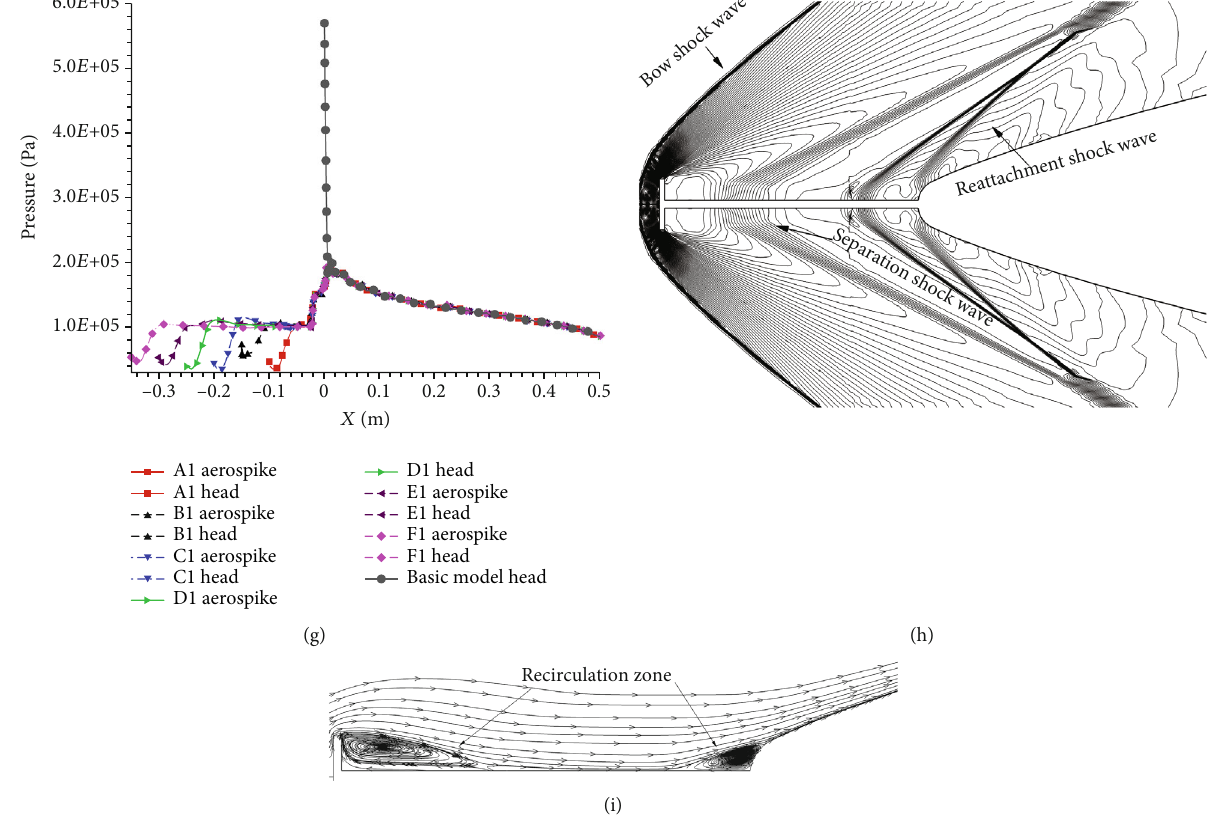
Figure 11: Flow fi eld features in Mach number 2. (a) L = 100 mm and r = 10 mm , pressure contour. (b) L = 200mm and r = 10 mm , pressure contour. (c) L = 350mm and r = 10 mm , pressure contour. (d) L = 100 mm and r = 10mm , velocity contour. (e) L = 200mm and r = 10mm , velocity contour. (f) L = 350mm and r = 10 mm , velocity contour. (g) r = 10mm , pressure curves (h). L = 100mm and r = 10 mm , pressure lines. (i) L = 100mm and r = 10 mm ,